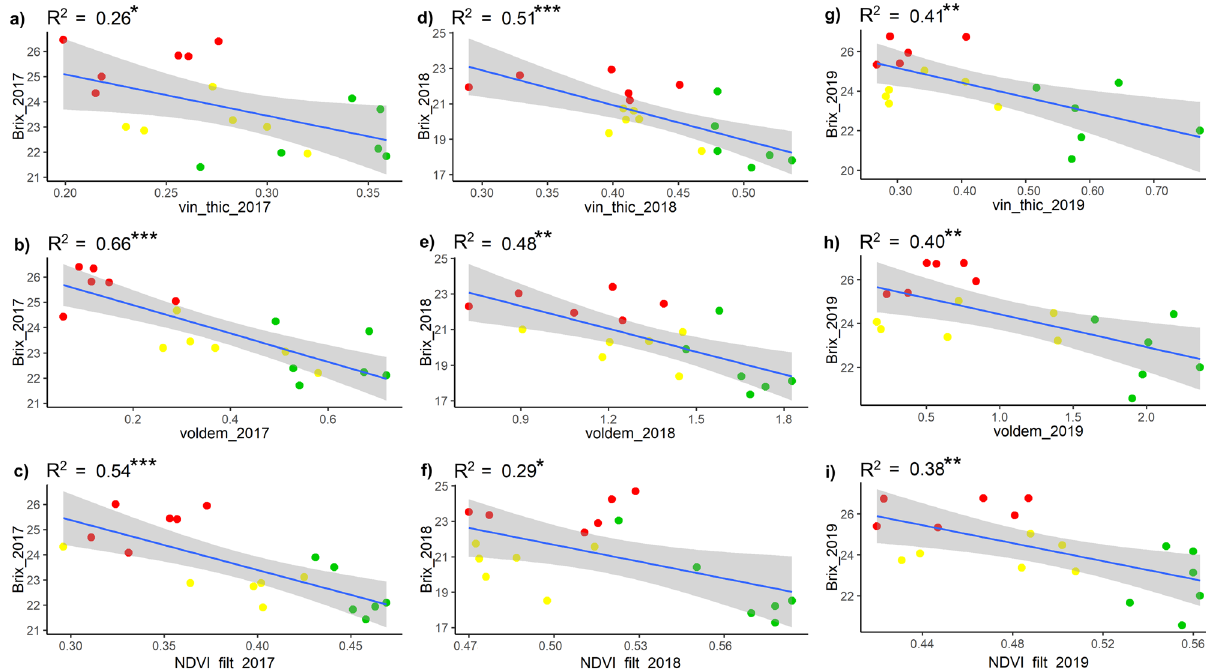
Figure 4. Linear regression results between ground measurements of total soluble solids (°Brix) and UAV remote sensed data, represented by NDVI filtered, canopy thickness (m) and volume (m 3 ) in the HV (green dots), MV (yellow dots) and LV (red dots) zones. Significance: *** p < 0.001; ** p < 0.01; * p <